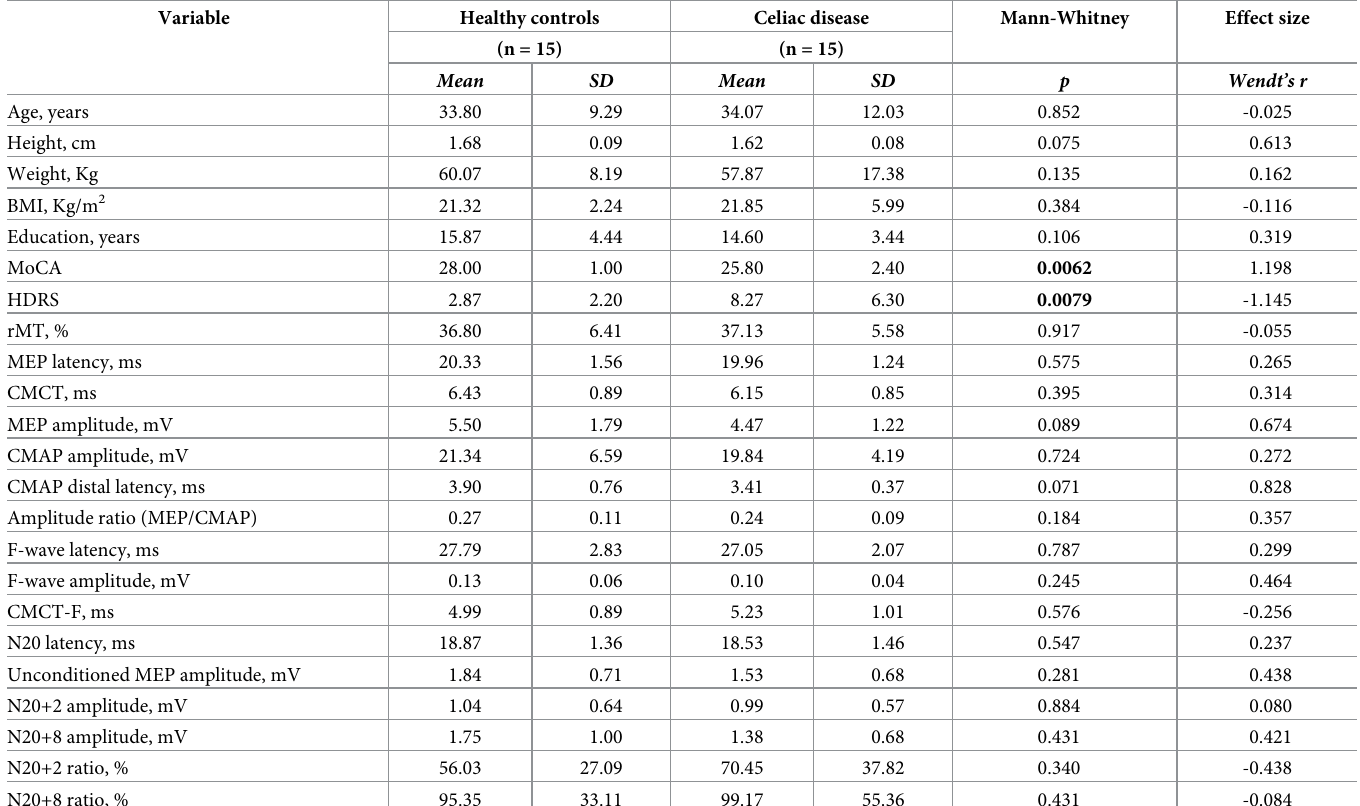
Table 2. Comparison of demographic features and TMS data of both patients and controls.